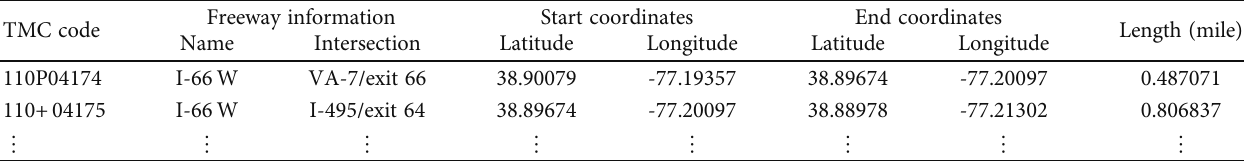
Table 2: TMC segments information format.